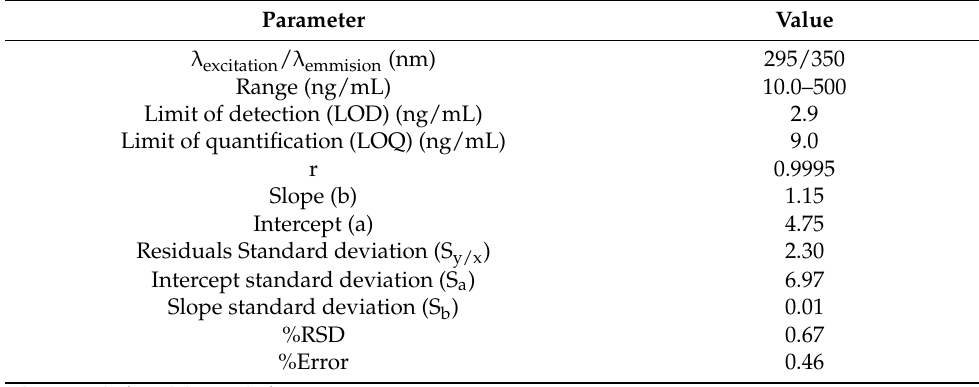
Table 1. Analytical parameters for determination of NFZ by the proposed fluorimetric